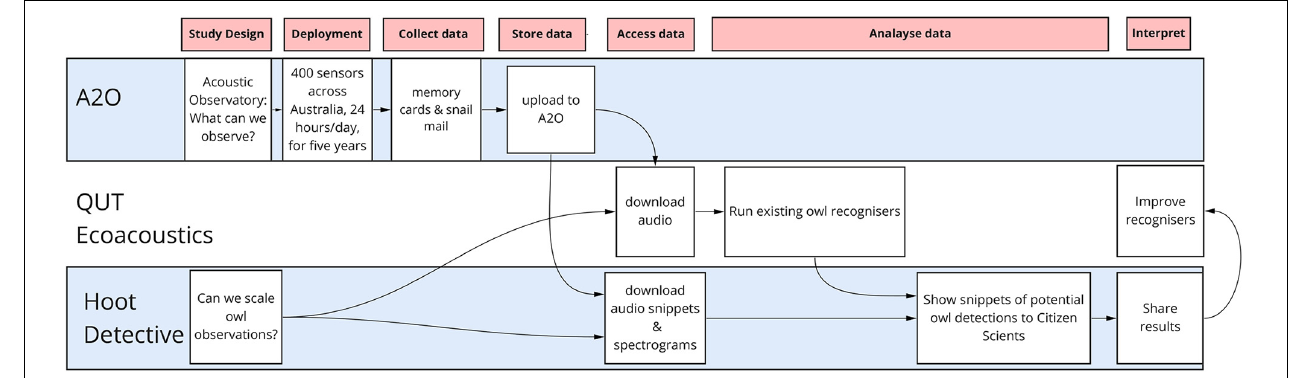
FIGURE 2 | Example workflow of species occupancy